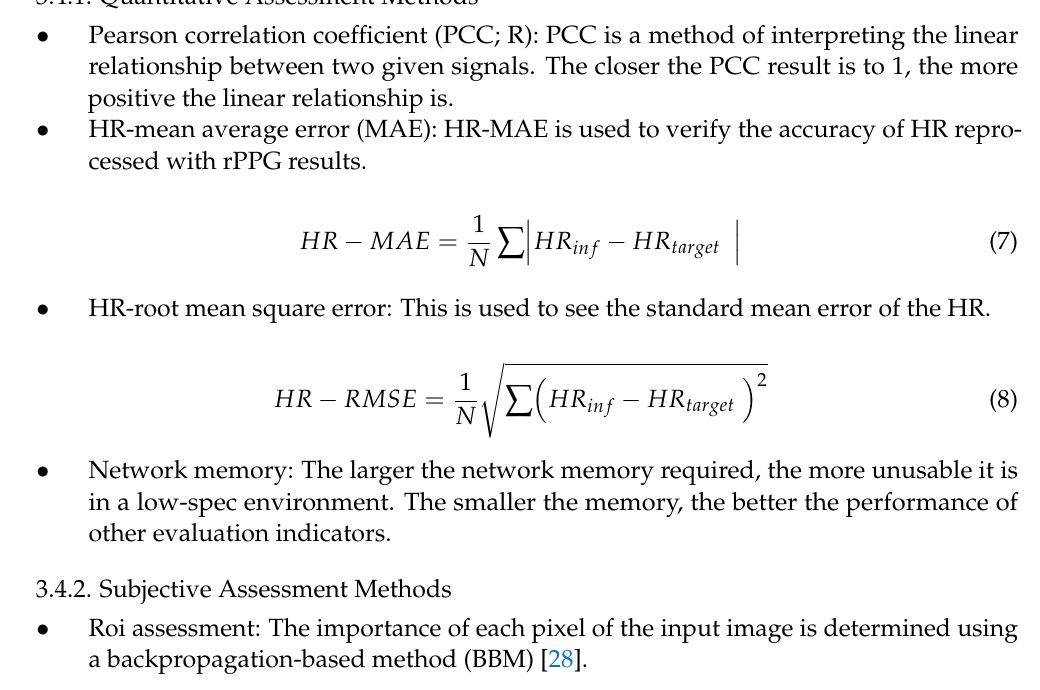
Figure 4 is an image of a PPG extraction accuracy evaluation, according to face area. According to [29], upper medial forehead, lower medial forehead, glabella, right malar, and left malar pixel data are important.